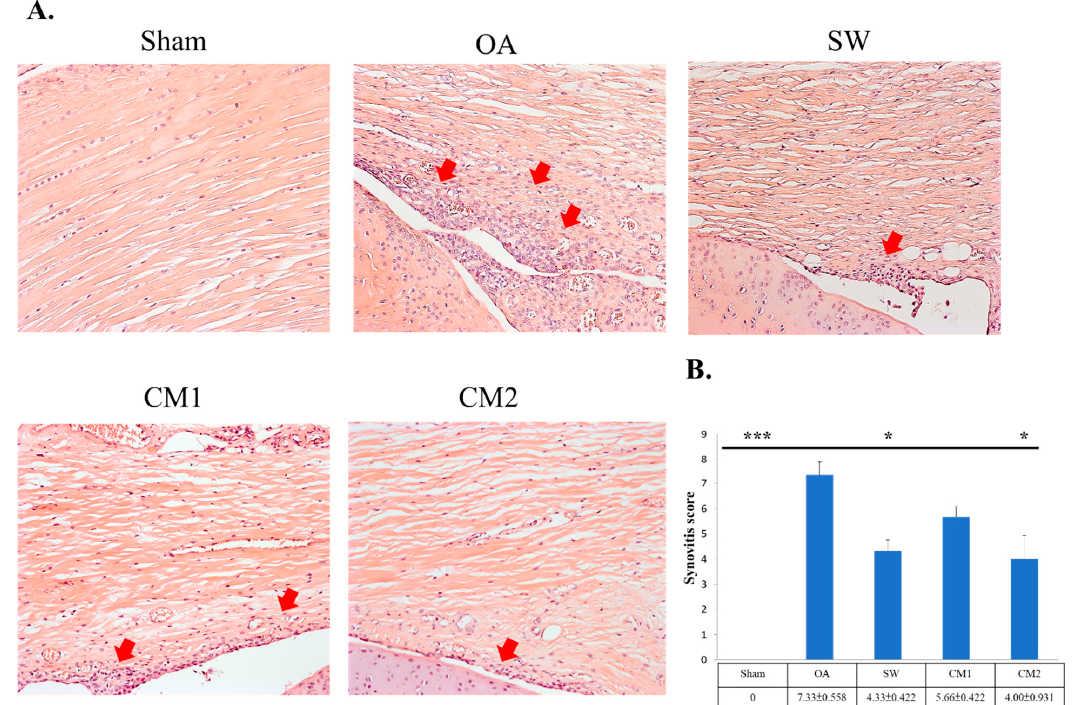
Figure 3. Evaluation of histological changes in the synovium membrane of rats with osteoarthritis (OA) after treatments. ( A ) The sections of synovium were observed by hematoxylin and eosin staining with 200× magnification. The lining cell layer, infiltration of mononuclear cells, and neutrophils are indicated by arrows. ( B ) The synovitis scores were calculated for each group. * p < 0.05 and *** p < 0.001 as compared with the OA group. Eight rats were used for each group. Osteoarthritis is indicated as OA. Shockwave is indicated as SW. The 100 and 200 μ L adipose-derived mesenchymal stem cells-conditioned medium groups are indicated as CM1 and CM2, respectively.